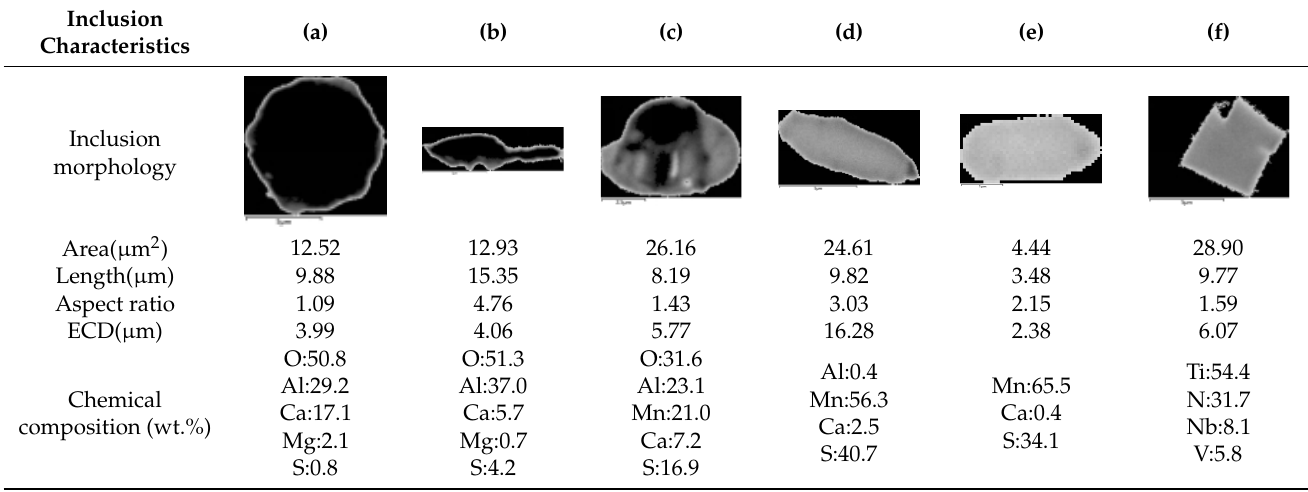
Table 4. The classification rules of inclusions.